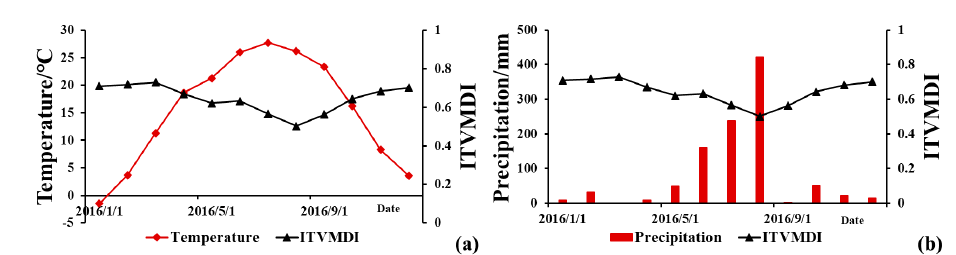
Figure5. ImprovedTemperature–Vegetation–SoilMoistureDrynessIndex(iTVMDI)andmeteorological Figure 5. Improved Temperature–Vegetation–Soil Moisture Dryness Index (iTVMDI) and data in Jinan, Shandong Province, China: ( a ) temperature and ( b ) meteorological data in Jinan, Shandong Province, China: ( a ) temperature and ( b ) precipitation.